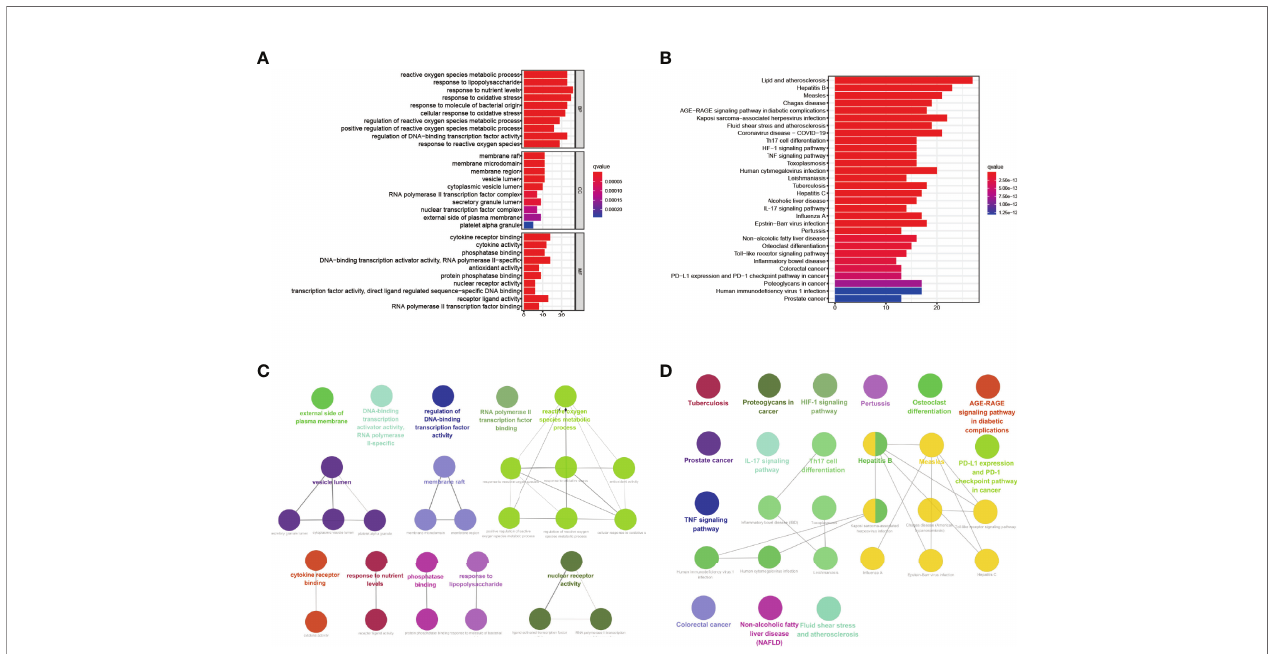
FIGURE 4 | GO term and KEGG pathway enrichment analysis of puerarin, COVID-19, and EHF common genes (only the top 30 results). (A, C) exhibited the GO term and KEGG pathway enrichment analysis results of common genes, respectively. (B, D) exhibited the correlation analysis of the GO term and KEGG pathway enrichment analysis results of common genes,